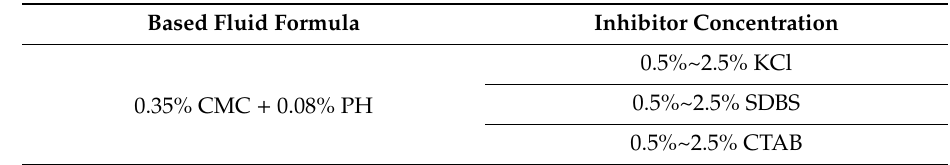
Table 1. Compositions of drilling fluid